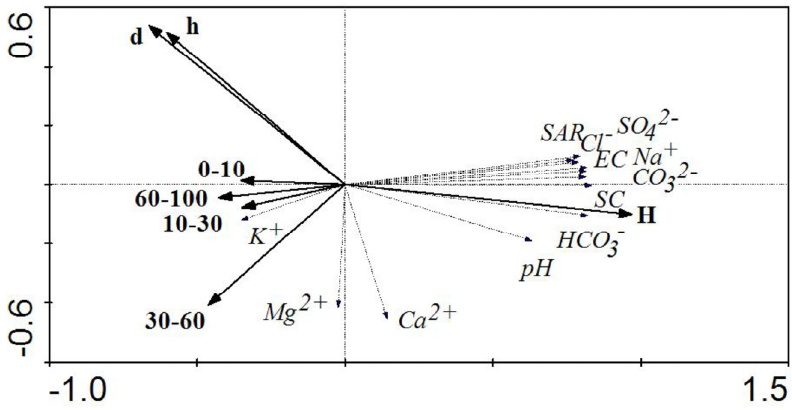
Figure 5. RDA 2D Ordination Diagram for Soil Salinity and Environment Factors in dry year. Table 4. Pearson correlation analysis between salinity and sodicity and environmental